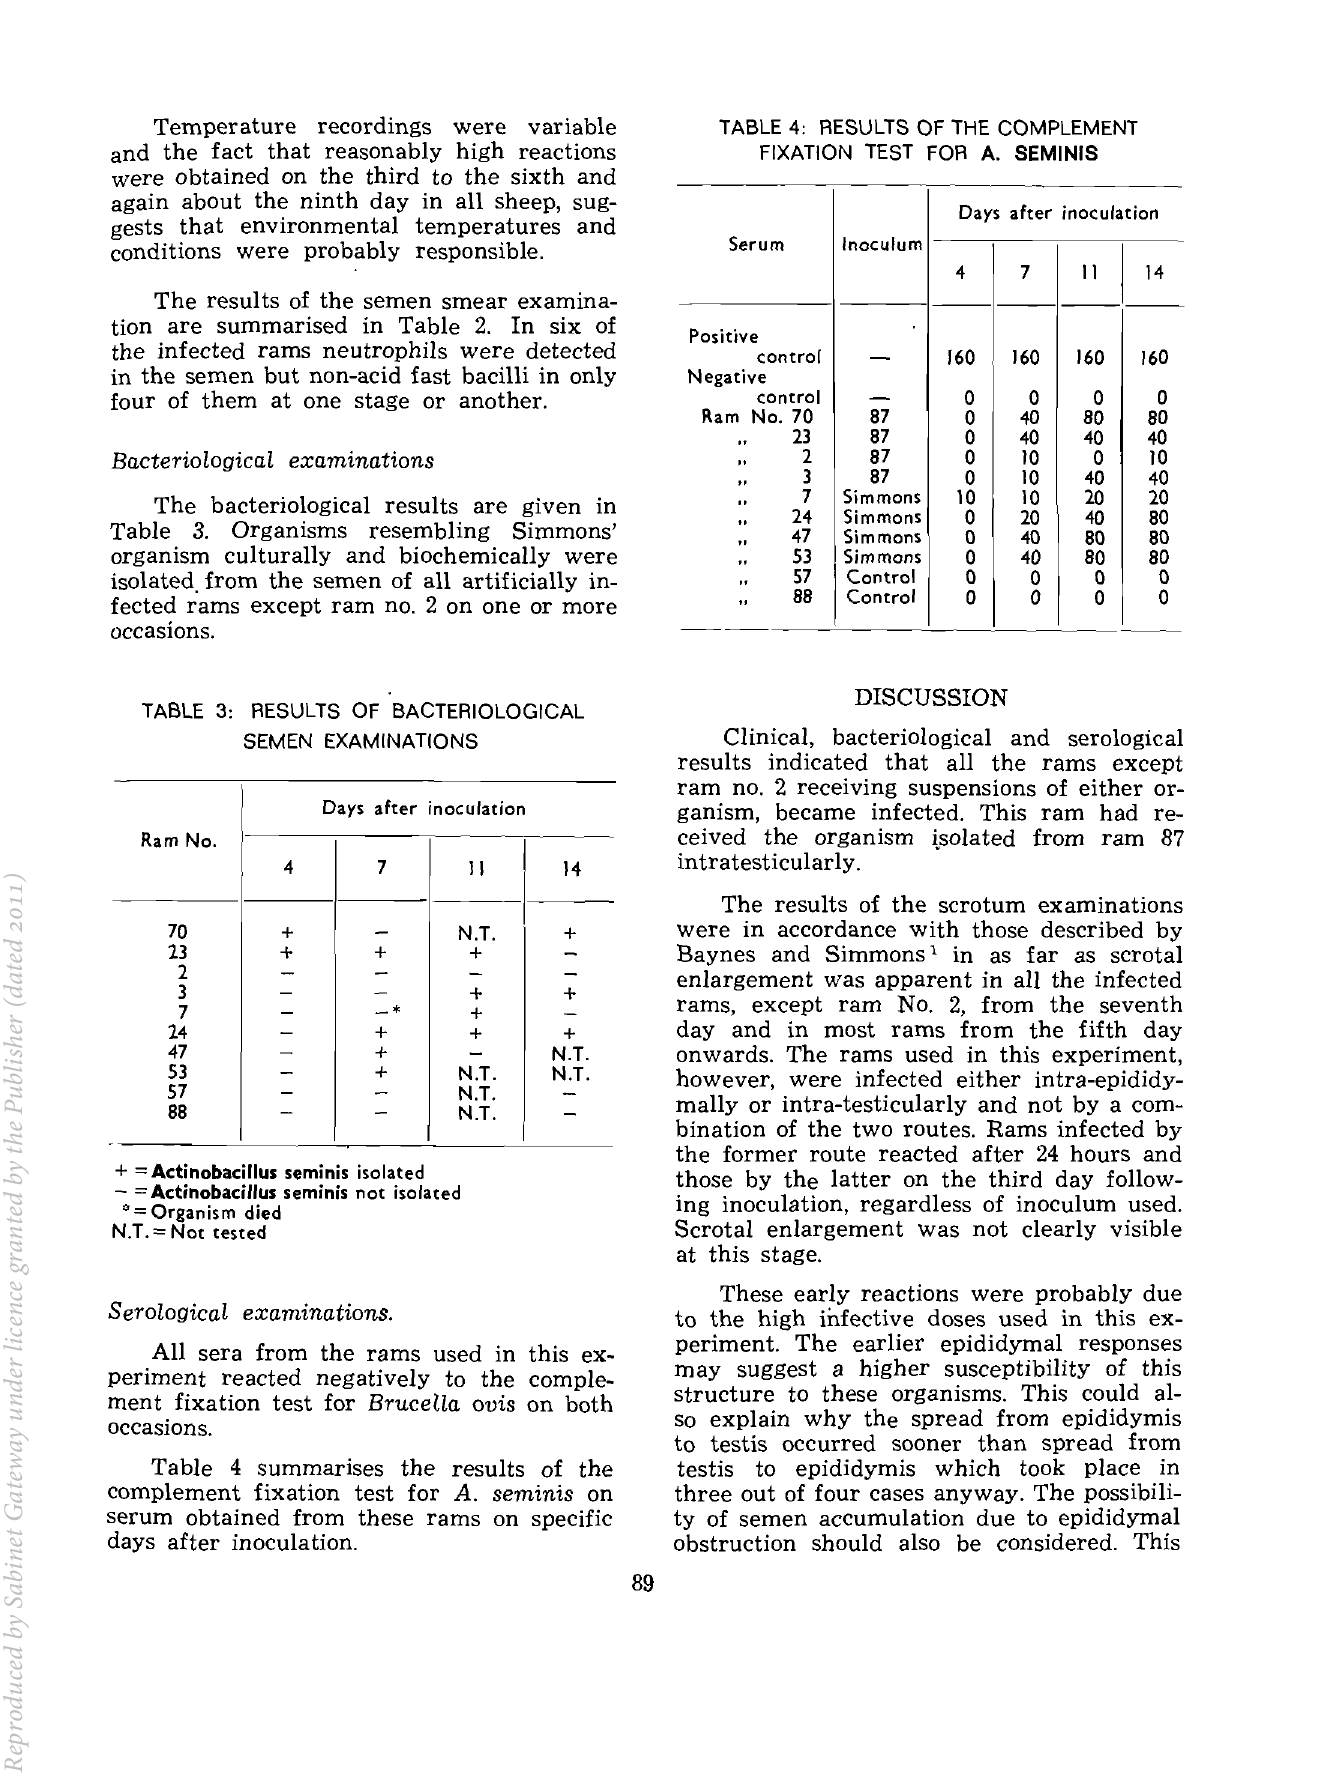
TABLE 4: RESULTS OF THE